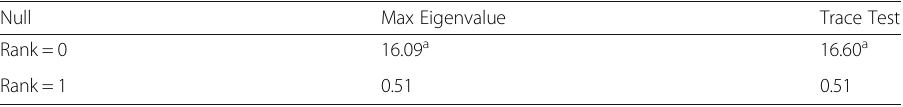
Table 2 Cointegration results Null Max